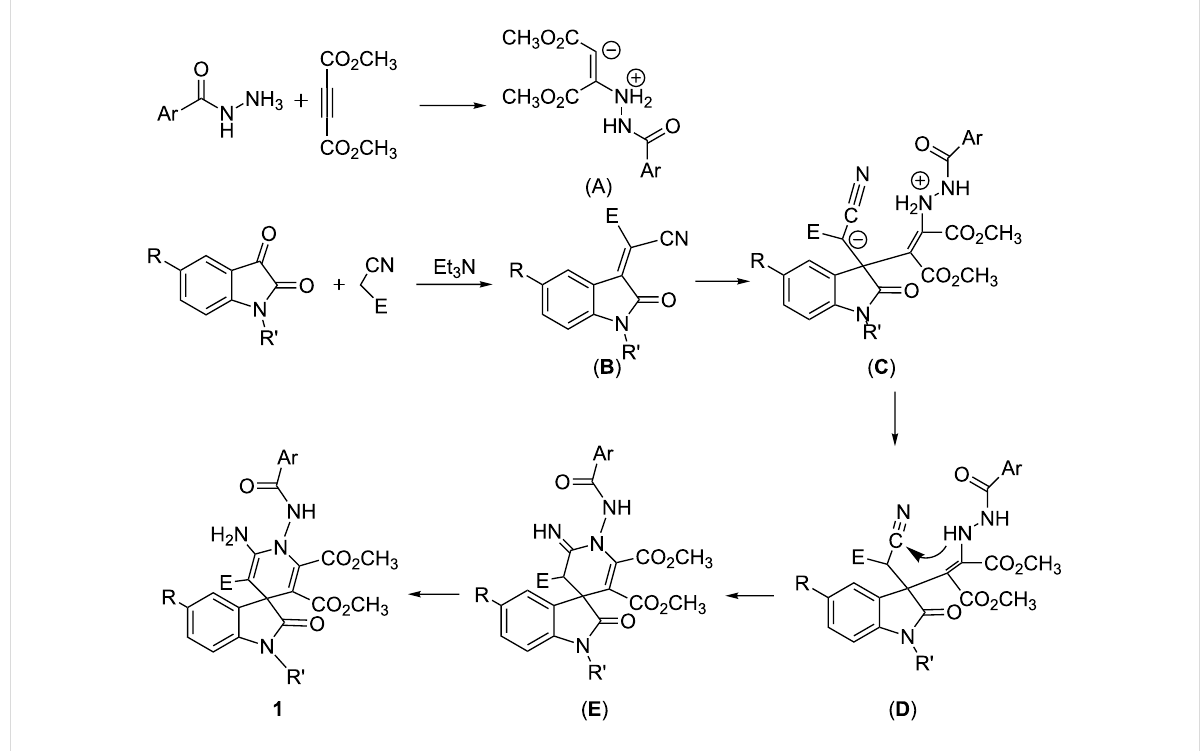
Scheme 2: Proposed reaction mechanism for the four-component reaction.